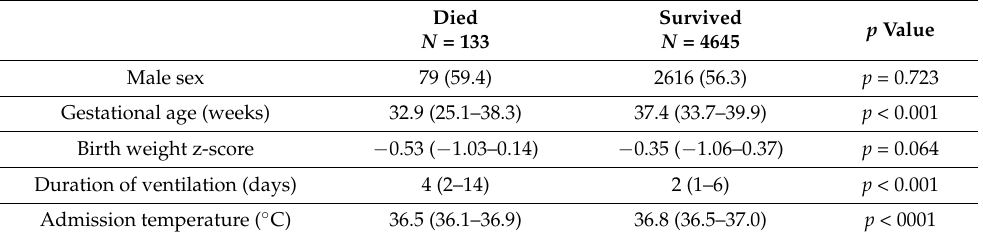
Table 3. Binary logistic regression analysis with survival to discharge from neonatal care as the outcome